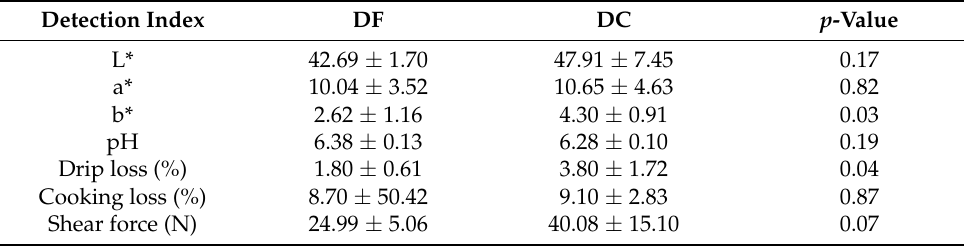
Figure 3. Maintenance behavior. DC: ducks kept within the combination of planting and breeding; DF: ducks kept in free range ( n = 50). Table 4. Meat quality traits in each